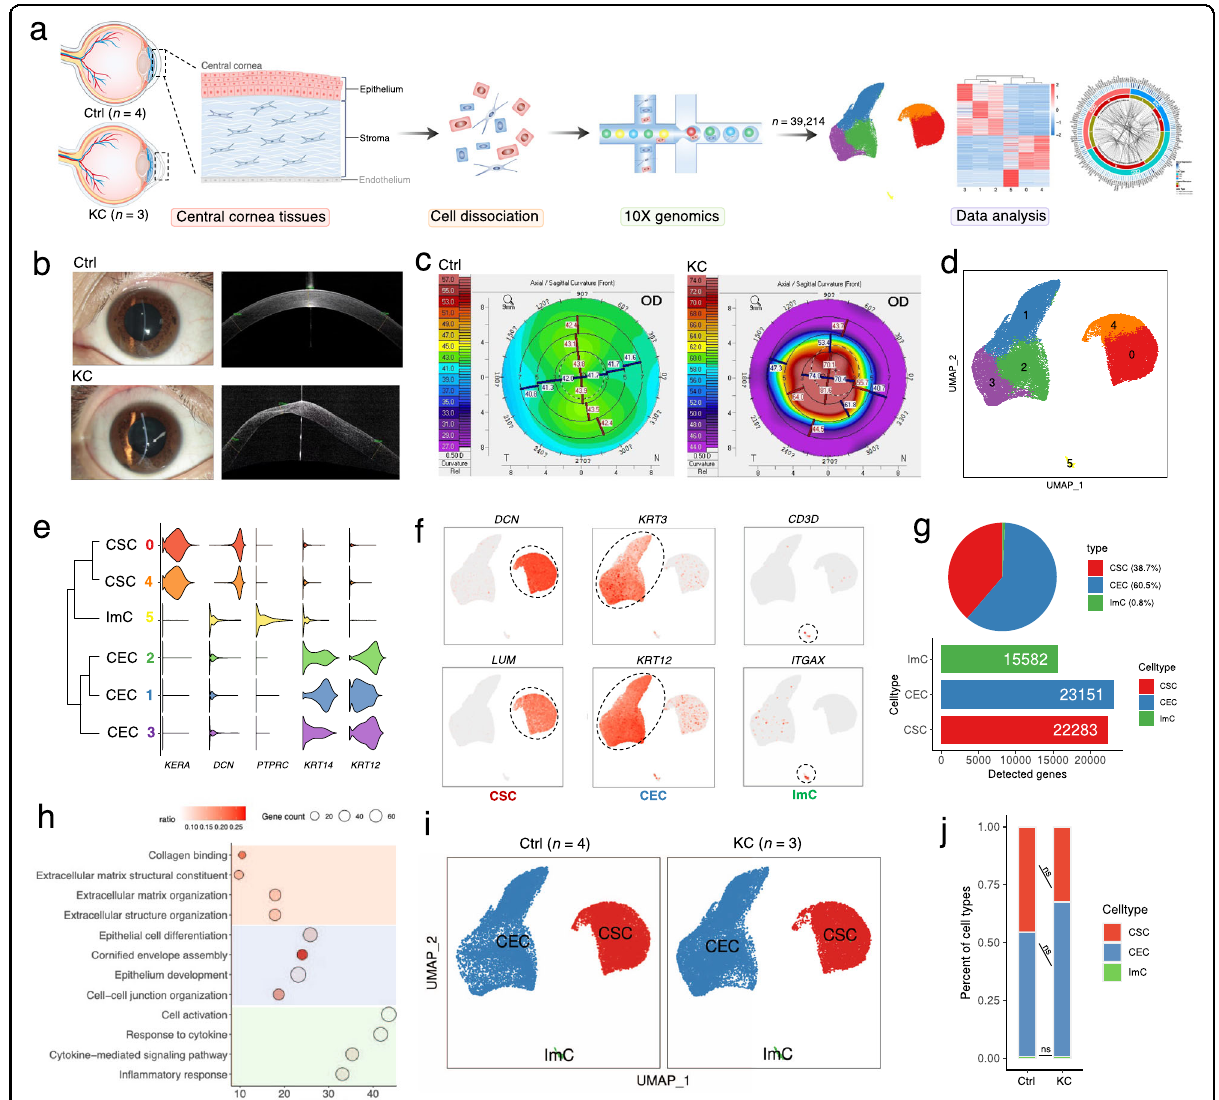
Fig. 1 Overview of cellular compositions of KC and Ctrl human corneas delineated by scRNA-Seq analysis. a Overview of the experimental work fl ow in this study. In the schematic of diagram of the human cornea, the corneal epithelium and stroma (labeled in black) from the central cornea were subjected to downstream experiments, and the corneal endothelium (labeled in gray) was excluded (see Materials and Methods). b , c Anterior segment OCT ( b ) and Scheimp fl ug optical cross-sectional analysis ( c ) showed typical symptoms of keratoconus cornea. d UMAP representation of human corneal cells colored into 6 distinct clusters. e , f Expression levels ( e ) and distribution ( f ) of well-known representative cell markers across clusters. g The cell type proportions (top panel) and the number of detected genes per cell type (bottom panel). h Representative GO terms of speci fi cally expressed genes in each cell type. i UMAP plot of human corneal cells colored by three major cell types in KC and Ctrl groups. j Bar plot representing the differences in relative proportion of major cell types between Ctrl and KC samples. ns, no signi fi cance (Student ’ s t -test). KC keratoconus; Ctrl control; CSC corneal stromal cell; CEC corneal epithelial cell; ImC immune